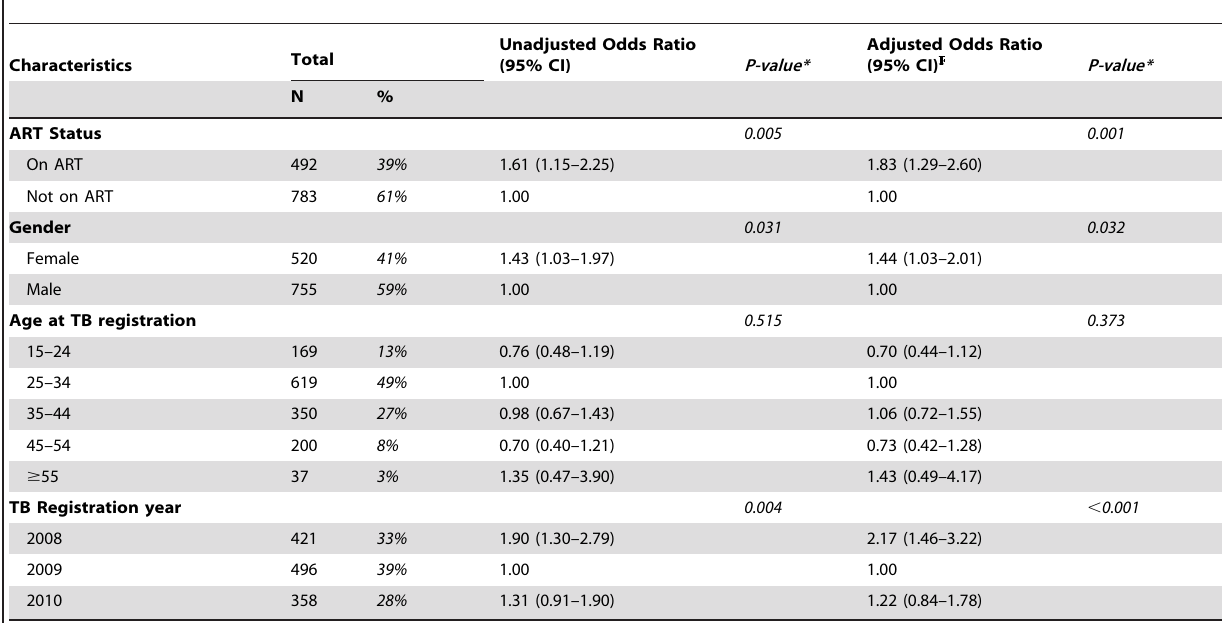
Table 4. Factors associated with TB treatment success among new smear-positive TB/HIV co-infected patients at Martin Preuss Centre between January 2008 and December 2010 ¥ (N